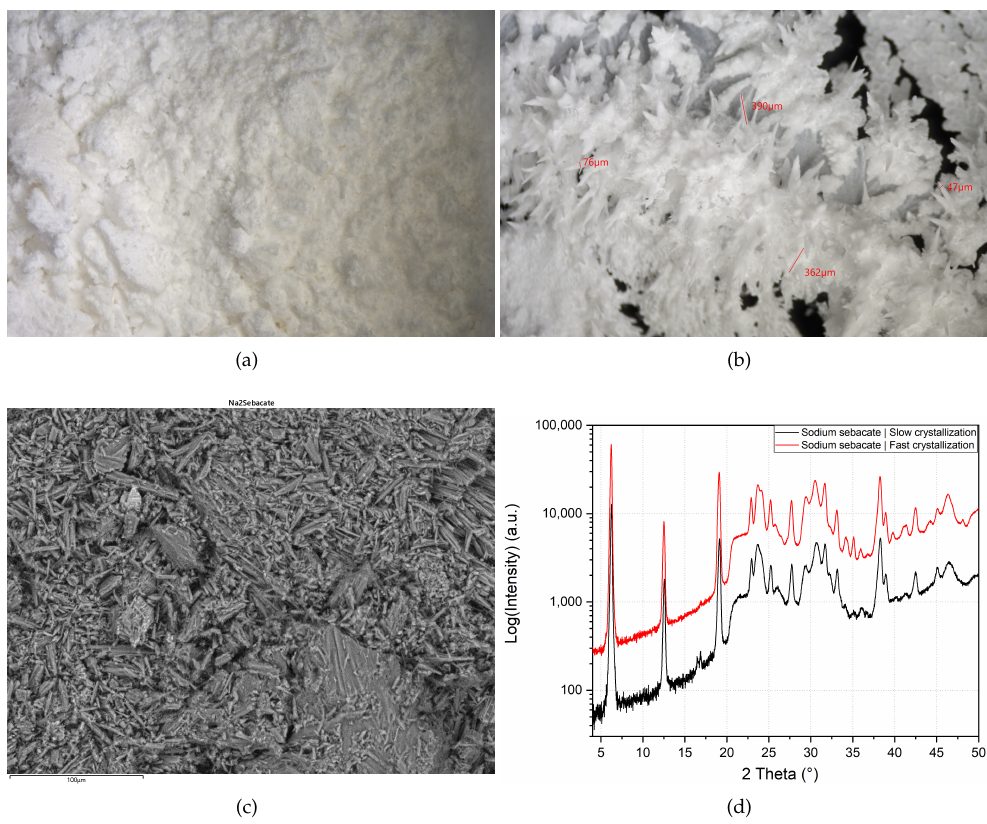
Figure 1. Optical images of fast ( a ) and slow ( b ) crystallization of sodium sebacate; SEM image ( c ) and XRPD pattern ( d ) of sodium sebacate (black: slow crystallization, red: fast crystallization).